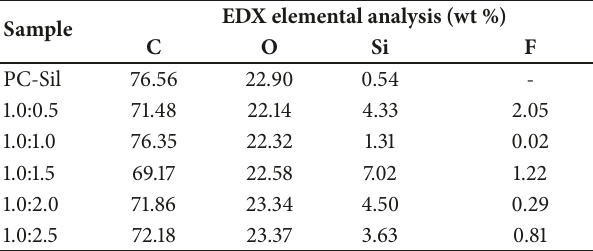
Table 3: EDX elemental analysis of fabricated